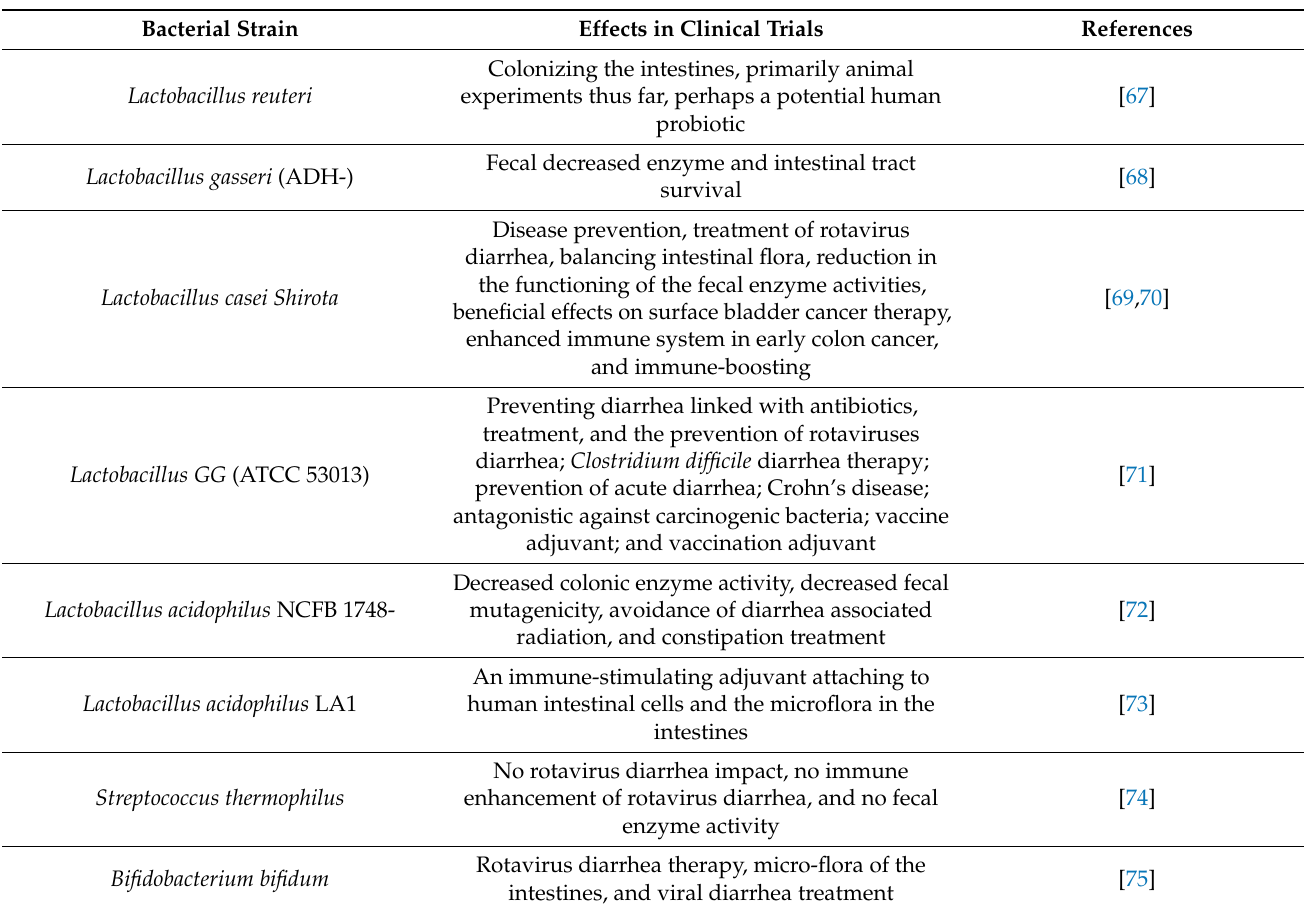
Table 2. The effect of gut microbes in human clinical